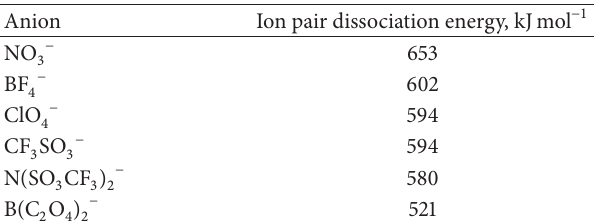
Table 2: Ion pair Li + A − dissociation energy obtained by means of quantum chemical calculations